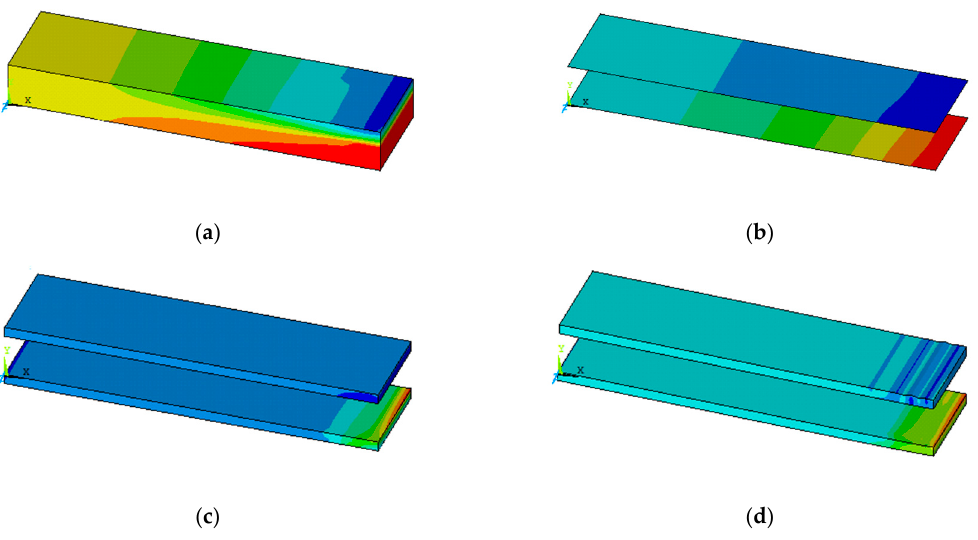
Figure 17. Principal strain map for specimen 2iMi2: ( a ) masonry, ( b ) TRM, ( c ) insulation in early loading stage, ( d ) insulation at the end of loading.